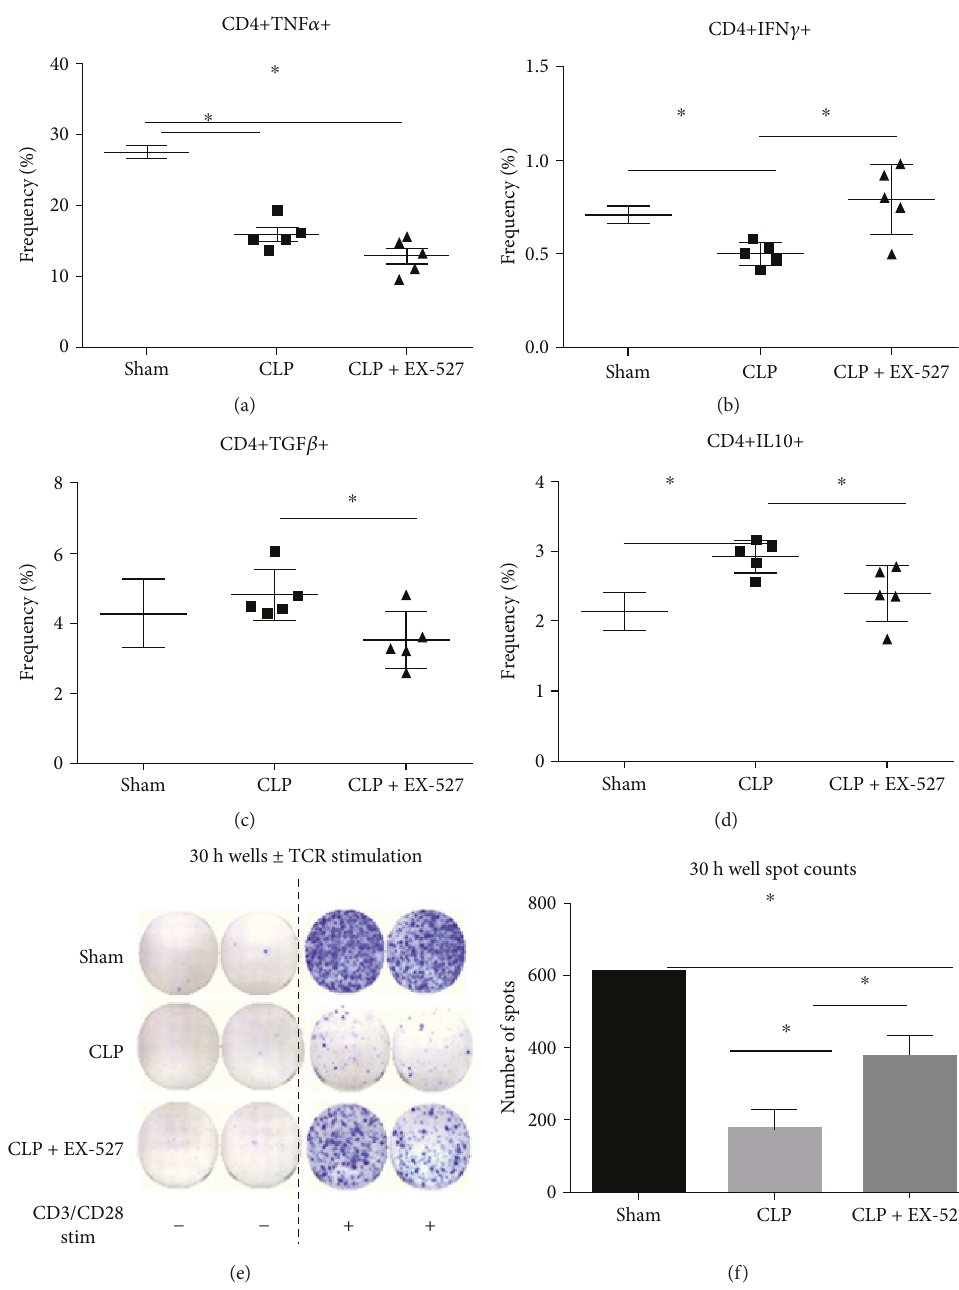
Figure 2: CD4+ T cell-associated cytokines are reprogrammed in a SIRT1-dependent manner. Cumulative scatterplot data of proin fl ammatory (a) CD4+TNF α + T cells and (b) CD4+IFN γ + T cells presented as frequency of CD4+ T cells in sham versus CLP versus CLP+EX-527. Cumulative scatterplot data of anti-in fl ammatory (c) CD4+TGF β + T cells and (d) CD4+IL10+ T cells presented as frequency of CD4+ T cells in sham versus CLP versus CLP+EX-527. (e) Representative ELISPOT data of IFN γ producing T cells ± restimulation from sham versus CLP versus CLP+EX-527 mice. (f) Cumulative results presented as spots counted per well from sham versus CLP versus CLP+EX-527, based on cells seeded at 3 × 10 5 cells/well. Data are expressed as mean ± SEM. (a – d) n = 5 mice/group; (e, f) n = 3 mice/group. ∗ p < 0 05